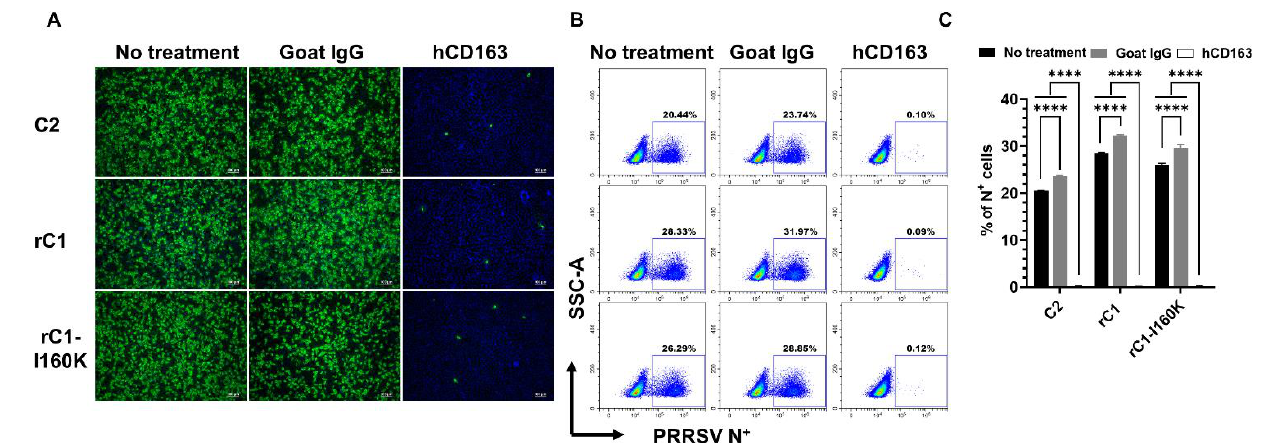
Figure 6. CD163 receptor is necessary for C1 virus infection. MARC-145 cells were preincubated with 10 µ g/100 µ L of either goat anti-human CD163 pAb or normal goat IgG for 1 h. Treated cells were inoculated with indicated viruses at a MOI of 2.5 TCID50 per cell and data was collected at 12 hpi. ( A ) Representative images of MARC-145 cells that were fixed and stained with an anti-N antibody to visualize virus-infected cells (green color). DAPI was used to stain the nuclei (blue color). Scale bar = 100 µ m. ( B ) Representative flowcytometry plots of MARC-145 cells that were fixed and stained with a FITC-labeled anti-N antibody. Uninfected cells were used to set-up gating. ( C ) Percentage of cells expressing N protein as quantified by flowcytometry. Data are presented as means and SEM of the three independent experiments. ns: non-statistically significant, **** p < 0.0001.